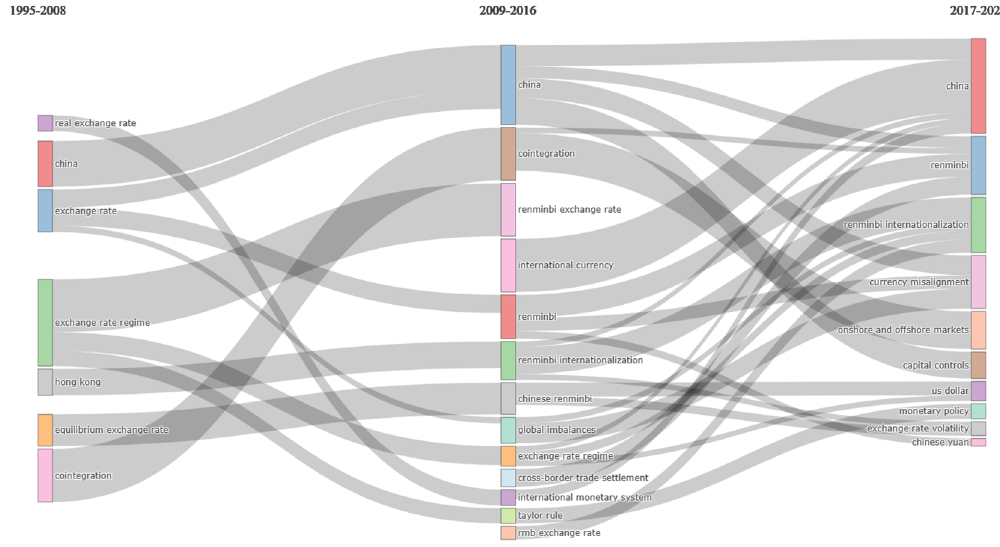
Figure 9. Thematic evolution of the renminbi literature (1995–2021). Source: Authors’ elaboration using Biblioshiny.